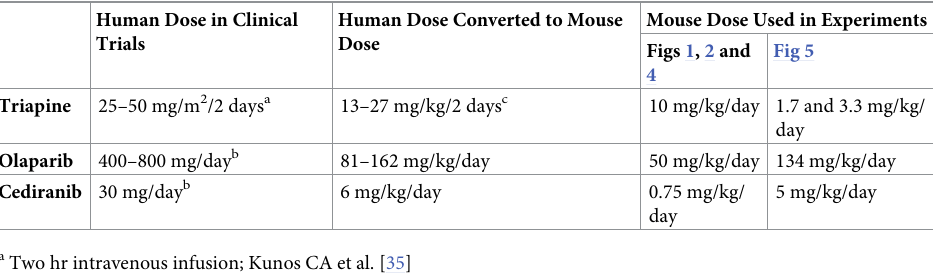
Table 1. Dose equivalency between human and